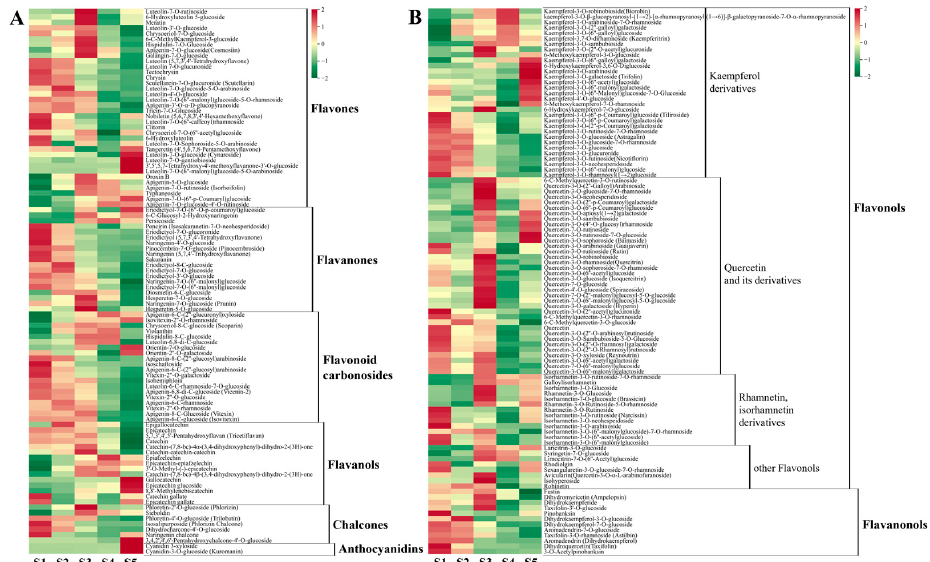
Figure 7. Cumulative distributions of flavonoids detected through broadly targeted UPLC-MC/MS at the five fruit developmental stages. ( A ) Metabolic heat map of flavonoids, flavanones, flavonoid carbonosides, flavanols, chalcones, and anthocyanidins; ( B ) metabolic heat map of flavonols and flavanonols.